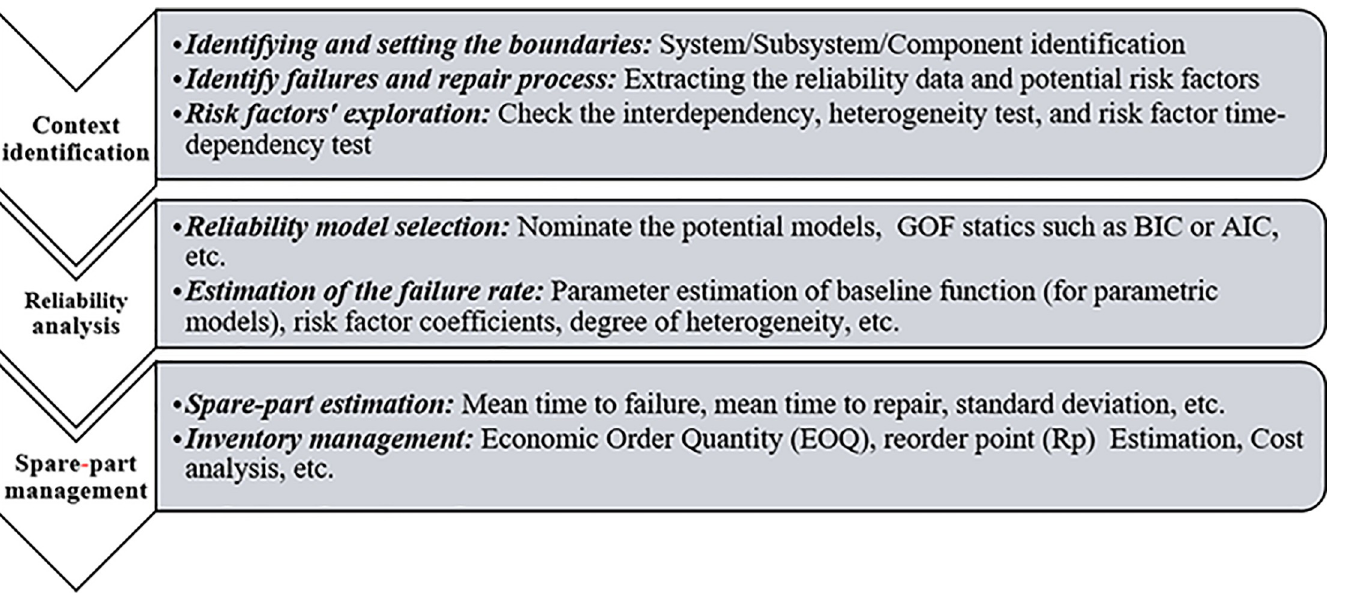
Fig 1. Spare parts based on reliability and risk